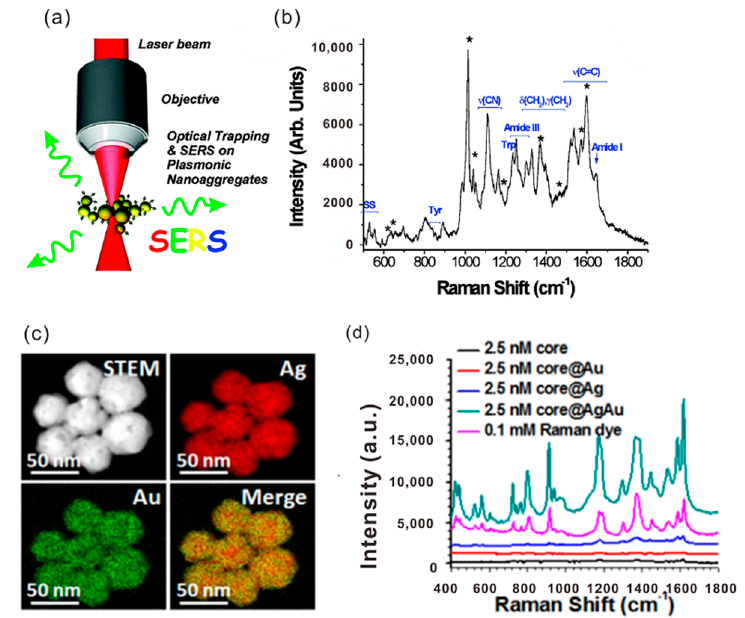
Figure 3. ( a ) Schematic of the Raman tweezing. Adapted from [30], with permission from © 2011 American Chemical Society. ( b ) Raman signals from the pyridine and bovine serum albumin adsorbed on the trapped Au NPs. ( c ) Elemental mapping of core@AgAu nanoparticles using high-resolution transmission electron microscopy. ( d ) Raman intensity of core, core@Au, core@Ag, core@AgAu NPs, and Raman dyes. Core represents 16-nm Au NPs coated with methoxy poly(ethylene glycol) thiol (mPEG-SH), Raman dyes, and Pluronic F127. Adapted from [11], with permission from © 2016 American Chemical